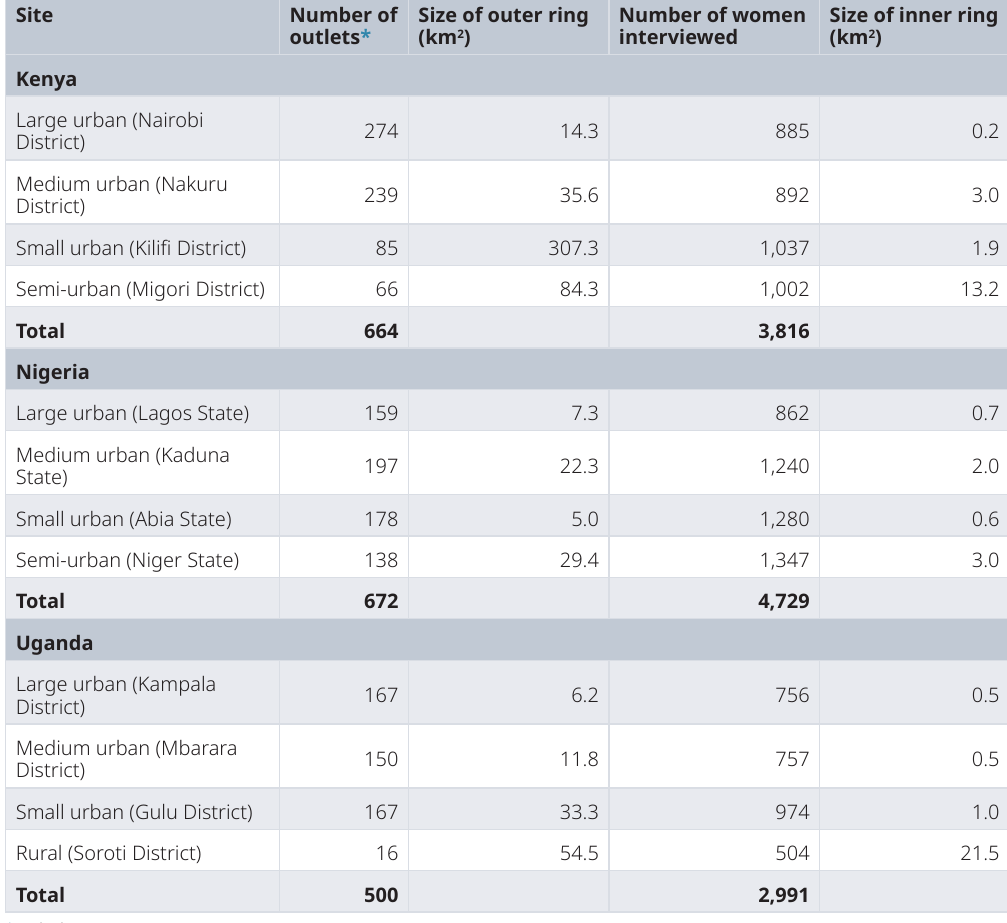
Table 1. Sample sizes and geographic areas of outer and inner rings by study site and round.